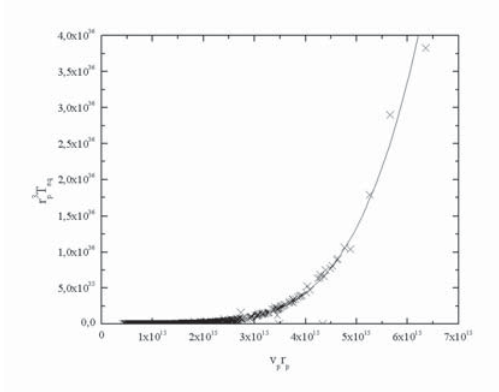
Fig. 5. Dependence of the parameters r 3 stellar spectral type K. According to the regression analysis, the best is the power interpolation with the coe ffi cient of determina- tion R 2 = 0 . 9688 for the parameter r 3